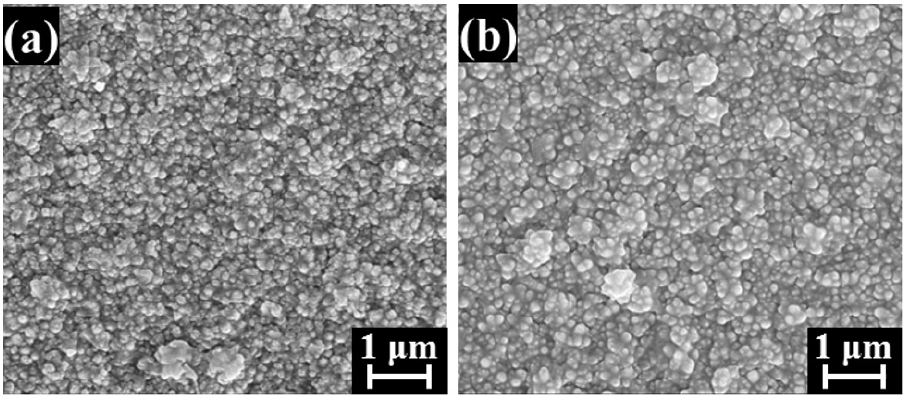
Figure 20. SEM topographical images of IPL treated CdTe. The films were treated using 100 pulses of light with an energy density of ( a ) 0 ( i.e ., as deposited), ( b ) 12.9, ( c ) 21.6, and ( d ) 25.9 J·cm − 2 . Note the gradual growth of grains, melting of the material and then sudden transformation of the layer into much larger grains creating gaps in between and increasing surface